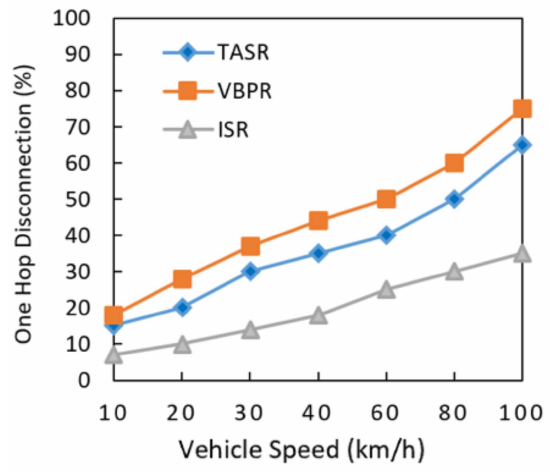
Figure 12. Comparison of one-hop link disconnection with increasing vehicle